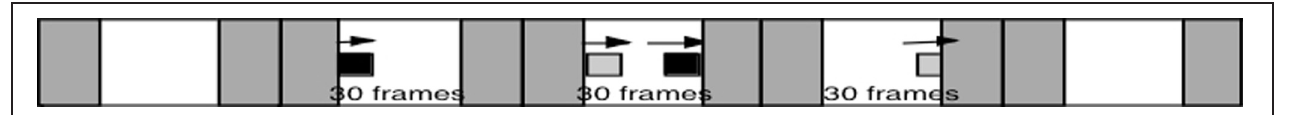
FIGURE 5 | Occluded reaction. B (the black square) emerges already in motion from the left, followed by A (the lighter square); both then disappear on the right; the amount of visible motion at a distance is as in a standard reaction.